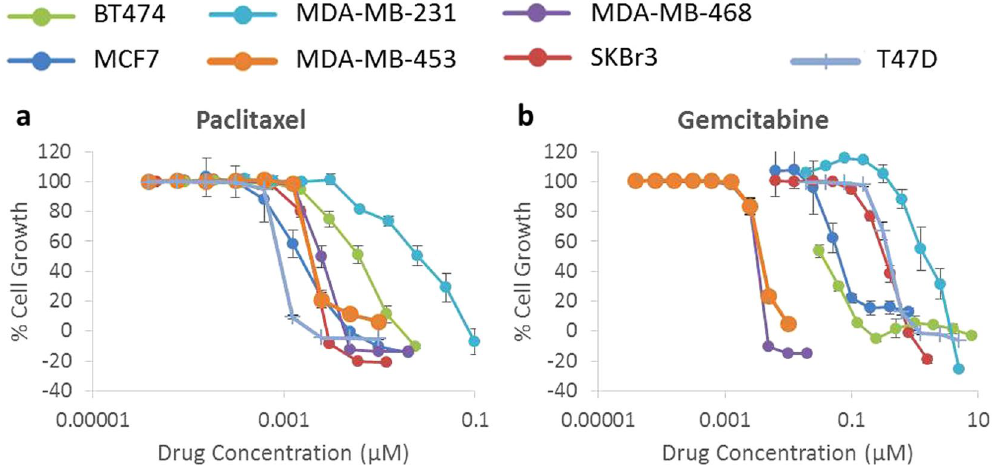
Figure 4. Growth control graphs showing effect of chemotherapeutic drugs paclitaxel and gemcitabine in doubling concentrations on growth of breast cancer cell lines. ( a ) Chemotherapy taxane paclitaxel. ( b ) Chemotherapy nucleoside analog gemcitabine. Paclitaxel was highly effective at inhibiting growth in all breast cancer cell lines, with IC50s ranging from 1 nM (T47D) to 24 nM (MDA-MB-231). Gemcitabine had moderate to high effects, with IC50s ranging from 3 nM (MDA-MB-468) to 1.389 µ M (MDA-MB-231). Each point is a representative of the mean ± SD of triplicate